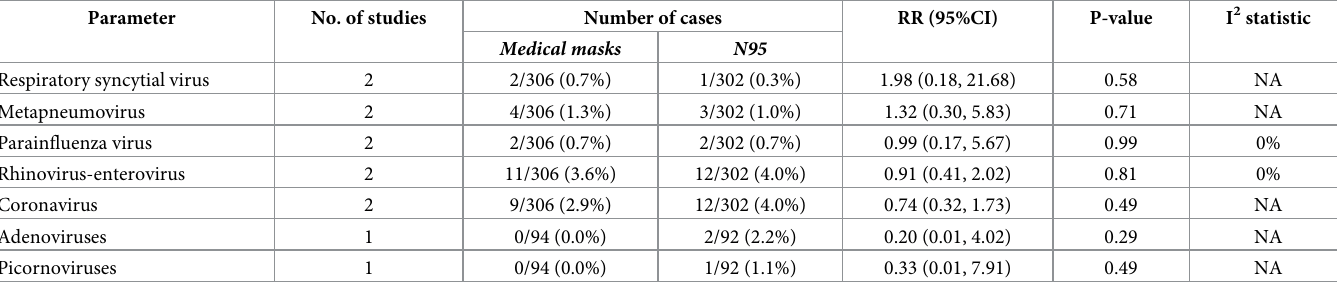
RR = Risk Ratio; CI = Confidence Interval; NA = Not applicable.